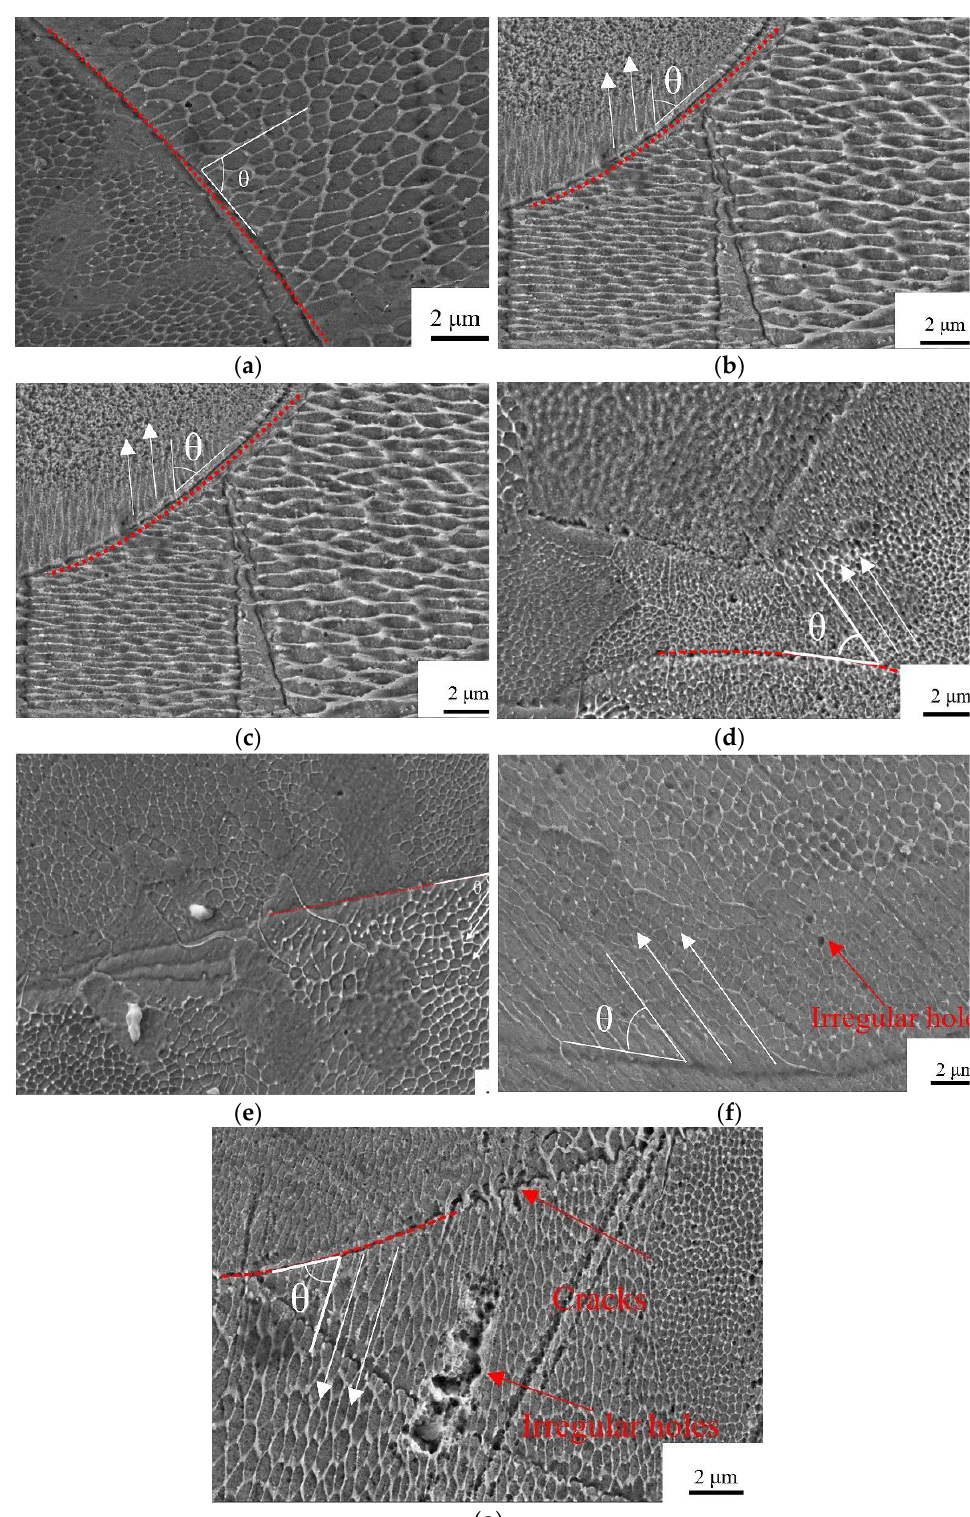
Figure 6. Organization of the melt pool with different energy densities: ( a ) ω = 41.7 J/mm 3 , ( b ) ω = 57.1 J/mm 3 , ( c ) ω = 67.7 J/mm 3 , ( d ) ω = 77.4 J/mm 3 , ( e ) ω = 83.3 J/mm 3 , ( f ) ω = 100.0 J/mm 3 , and ( g ) ω = 111.1 J/mm 3.